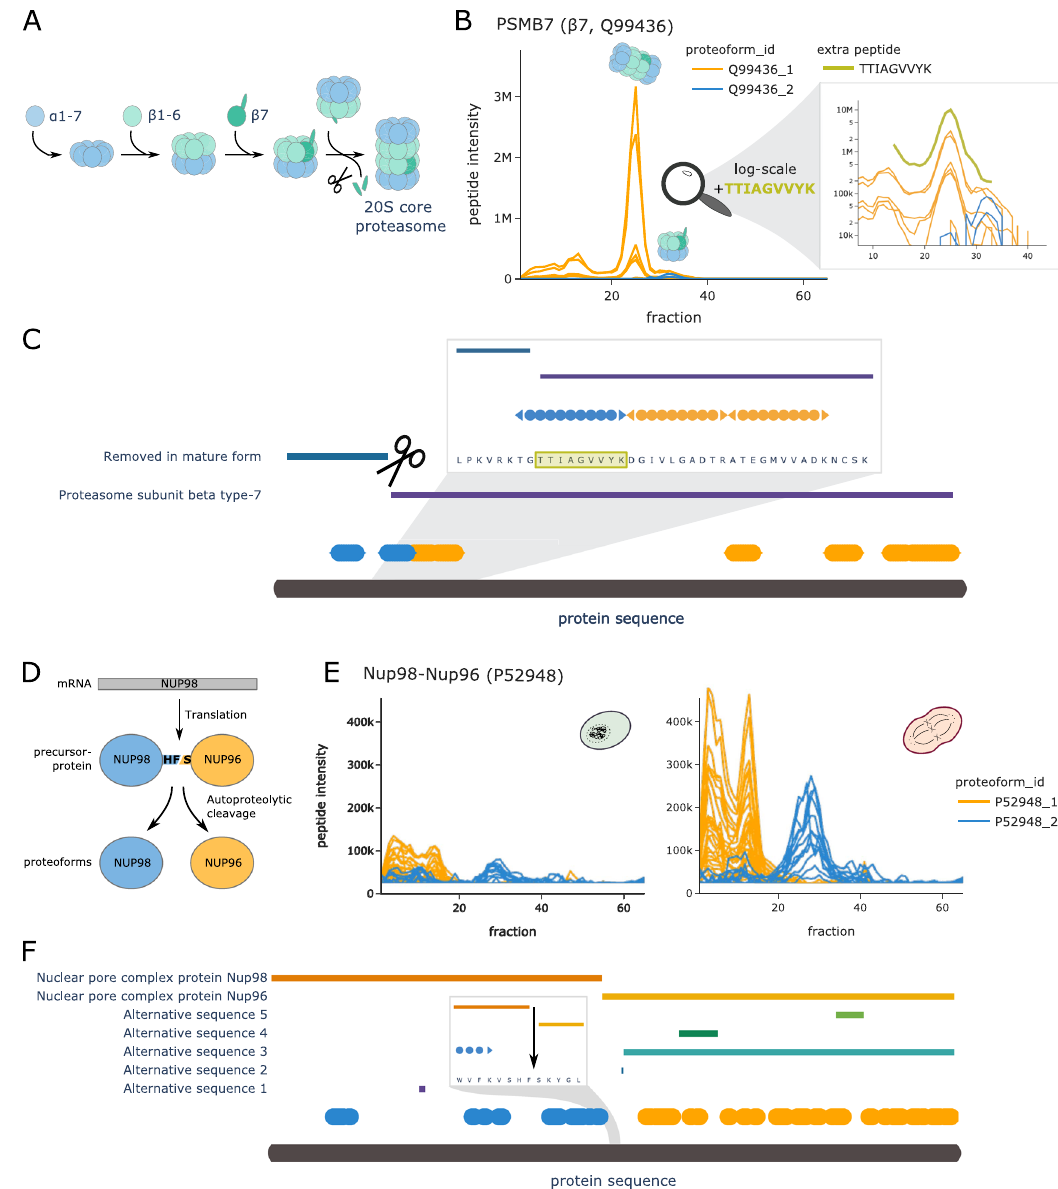
Fig. 4 COPF results for PSMB7 and NUP98/96. A Schematic overview of the proteasome assembly line. B Peptide pro fi les of the proteasome subunit- β type-7 ( β 7, PSMB7, UniProt ID: Q99436) in interphase. Peptides of the two assigned proteoform groups are colored in orange and blue. A zoom-in on fraction 10 to 40 is shown in log scale, including an additional semi-tryptic peptide TTIAGVVYK that represents the N-terminal tryptic peptide of the processed proteoform (green). Please note that the abundance values between the orange and blue peptides cannot be directly compared to the semi- tryptic peptide TTIAGVVYK in green because of the separate analysis platforms used. C Protein sequence plot for PSMB7. Sequence coverage and position of the detected peptides of the two assigned proteoform groups are indicated in blue and orange. Pro-peptide and chain information from UniProt are indicated as horizontal bars. The known pro-peptide cleavage site is indicated by scissors. A zoom-in representation is provided for the region around the annotated cleavage site. The semi-tryptic peptide from B is highlighted in green. D Schematic overview of the NUP98 and NUP96 proteoform biogenesis from the same mRNA and precursor protein (UniProt ID: P52948). E Peptide pro fi les of the Nup98 gene product in interphase (left) and mitosis (right). Peptides of the two assigned proteoform groups are colored in orange and blue. F Protein sequence plot for the Nup98 gene product. Sequence coverage and position of the detected peptides of the two assigned proteoform groups are indicated in blue and orange. Chain information and alternative sequence isoforms from UniProt are indicated as horizontal bars. The known autocatalytic cleavage site of NUP98/96 is shown as an arrow in a zoom-in on the relevant sequence